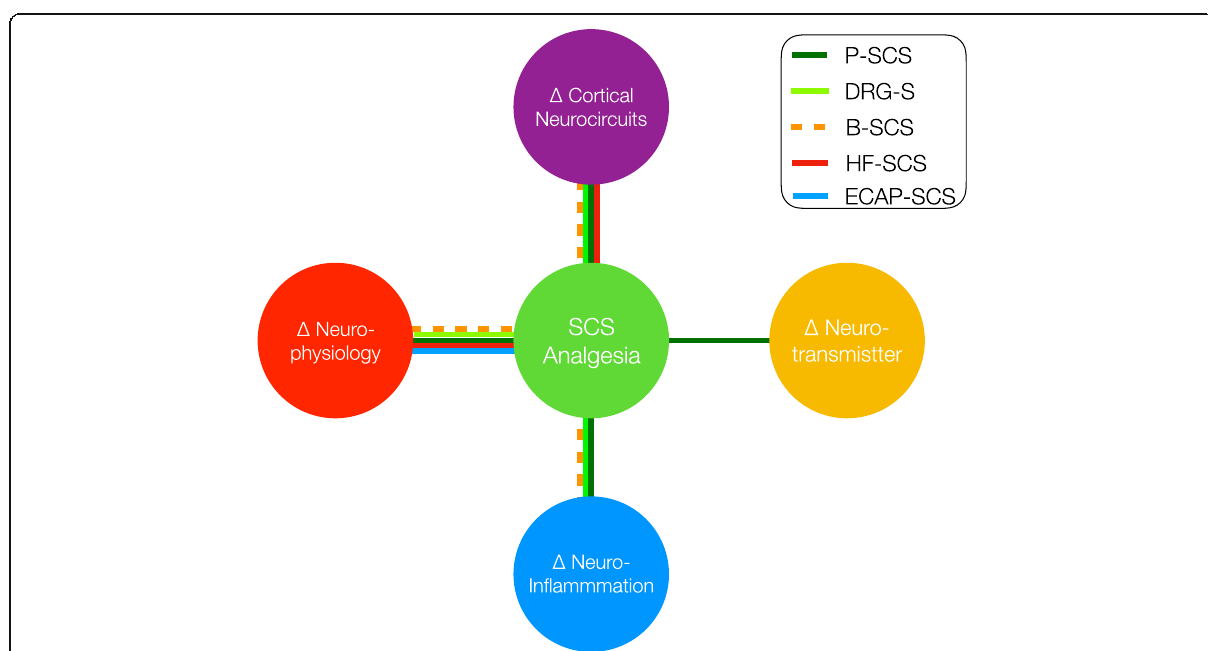
Fig. 12 The Current literature supports multiple domains of MOA of SCS. Major P-SCS, PF-SCS and DRG-S analgesic MOA include modulation of 1) segmental and supraspinal neurotransmitters, 2) segmental and supraspinal neurophysiology/neuroplasticity, 3) central and peripheral neuroinflammation and 4) cortical and subcortical neurocircuits. P-SCS has accrued the largest literature in support of all four MOA, while only P-SCS preclinical studies consistently demonstrate modulation of neurotransmitters critical to analgesia. Emerging and published literature support the concept that all SCS paradigms (P-SCS, B-SCS, DRG-S, HF-SCS, ECAP-SCS) contribute to altered neuronal activity (i.e. neurophysiological). Pre-clinical and clinical work support cortical neurocircuit